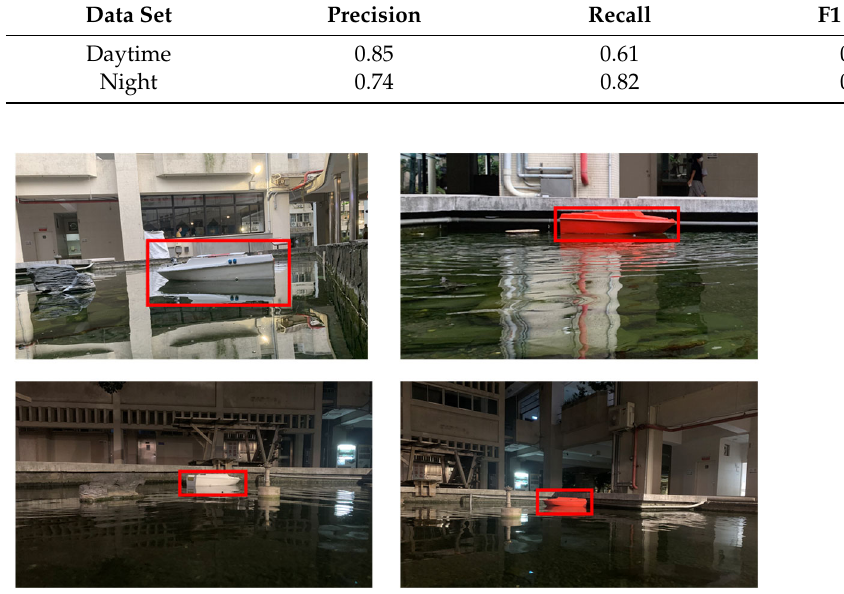
Figure 22. Different USV data sets during daytime and night.